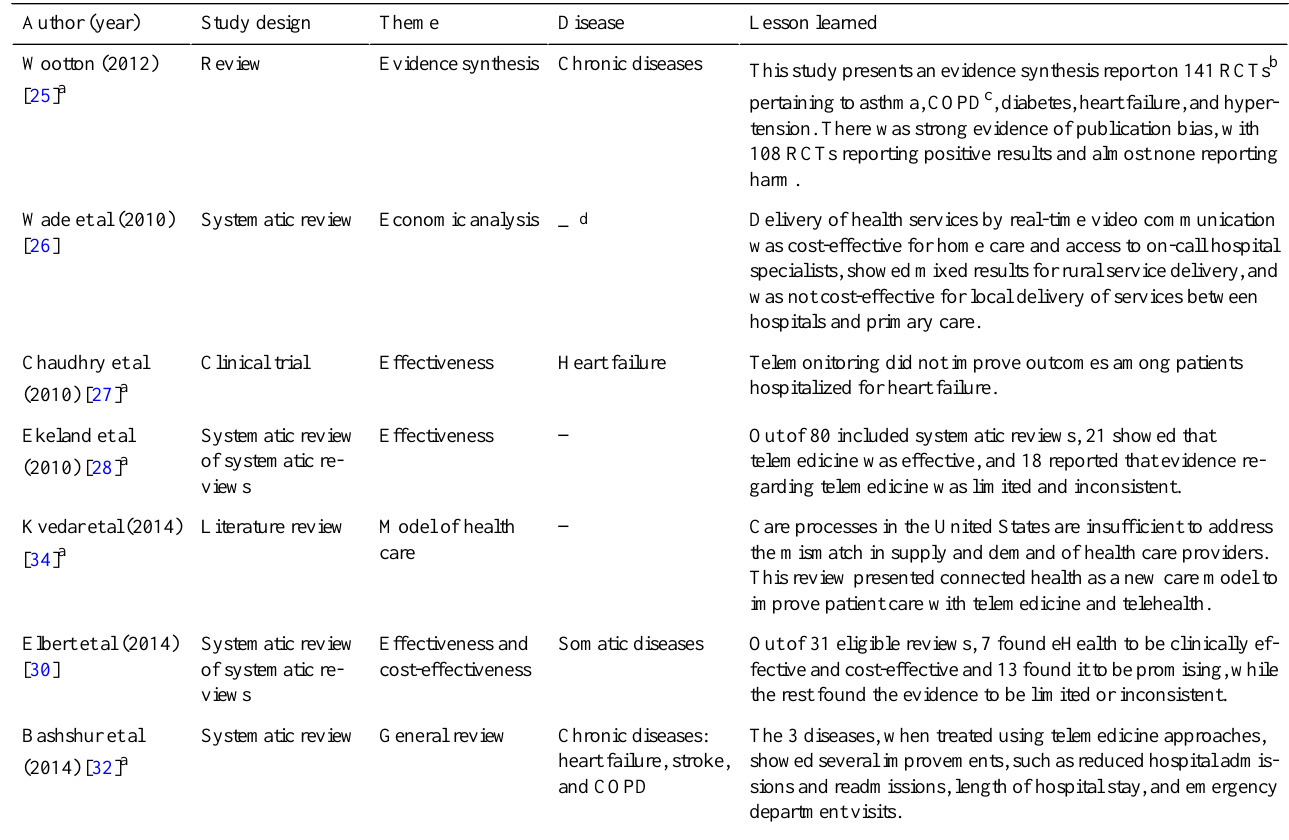
Lesson learnedDiseaseThemeStudy designAuthor